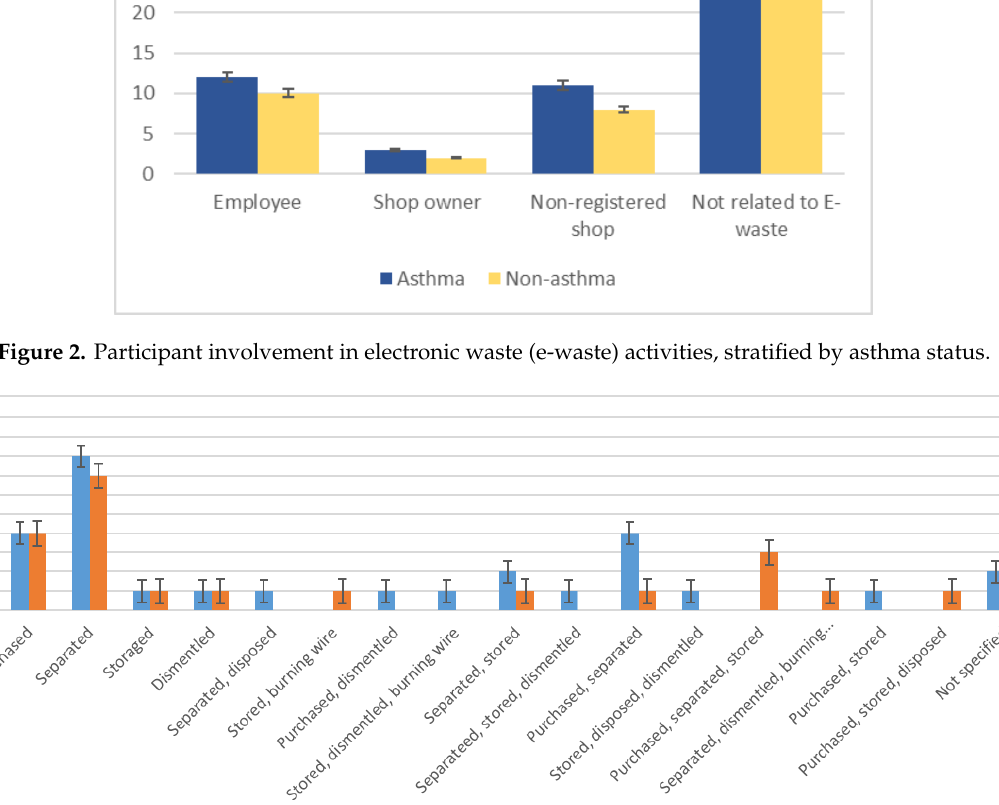
Figure 3. Participant involvement in specific steps of electronic waste handling, stratified by asthma status.